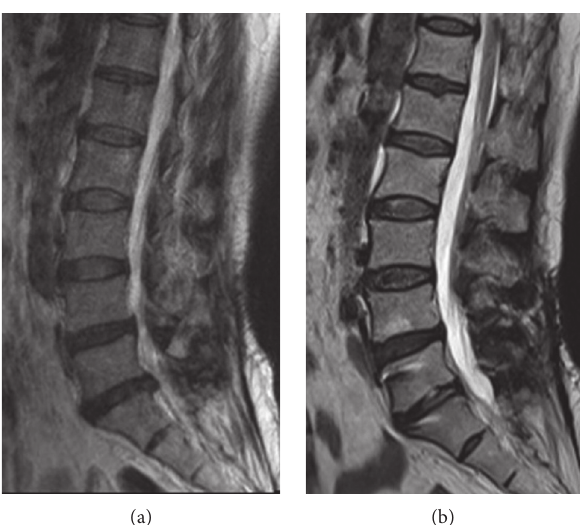
Figure 2: A case of a 53 years old female patient with RLDH at L5-S1. MRI scans showed rehydration at 22-month follow-up after transpedicular dynamic stabilization.